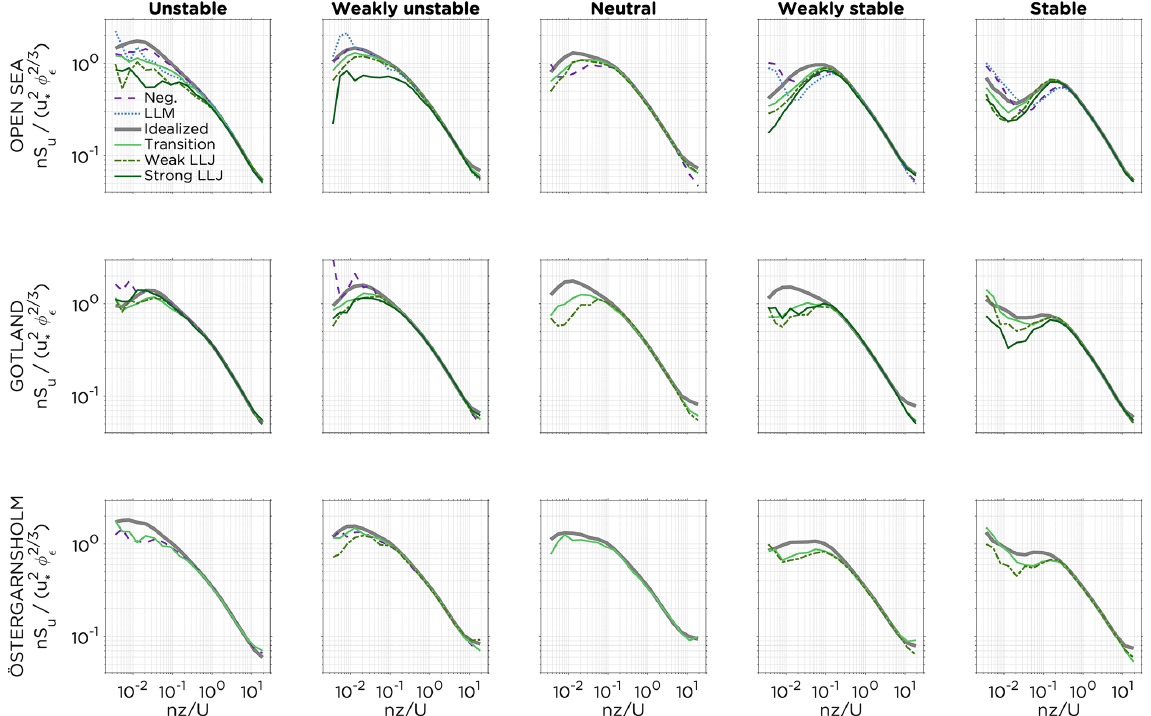
Figure 8. Median of the normalized turbulent u power spectra plotted against normalized frequency for the different types of profiles occurring in the different wind direction sectors and under different atmospheric stabilities. A minimum of 20 occurrences of each type of profile per category was used as a limit to include the statistics for the profile; see Table